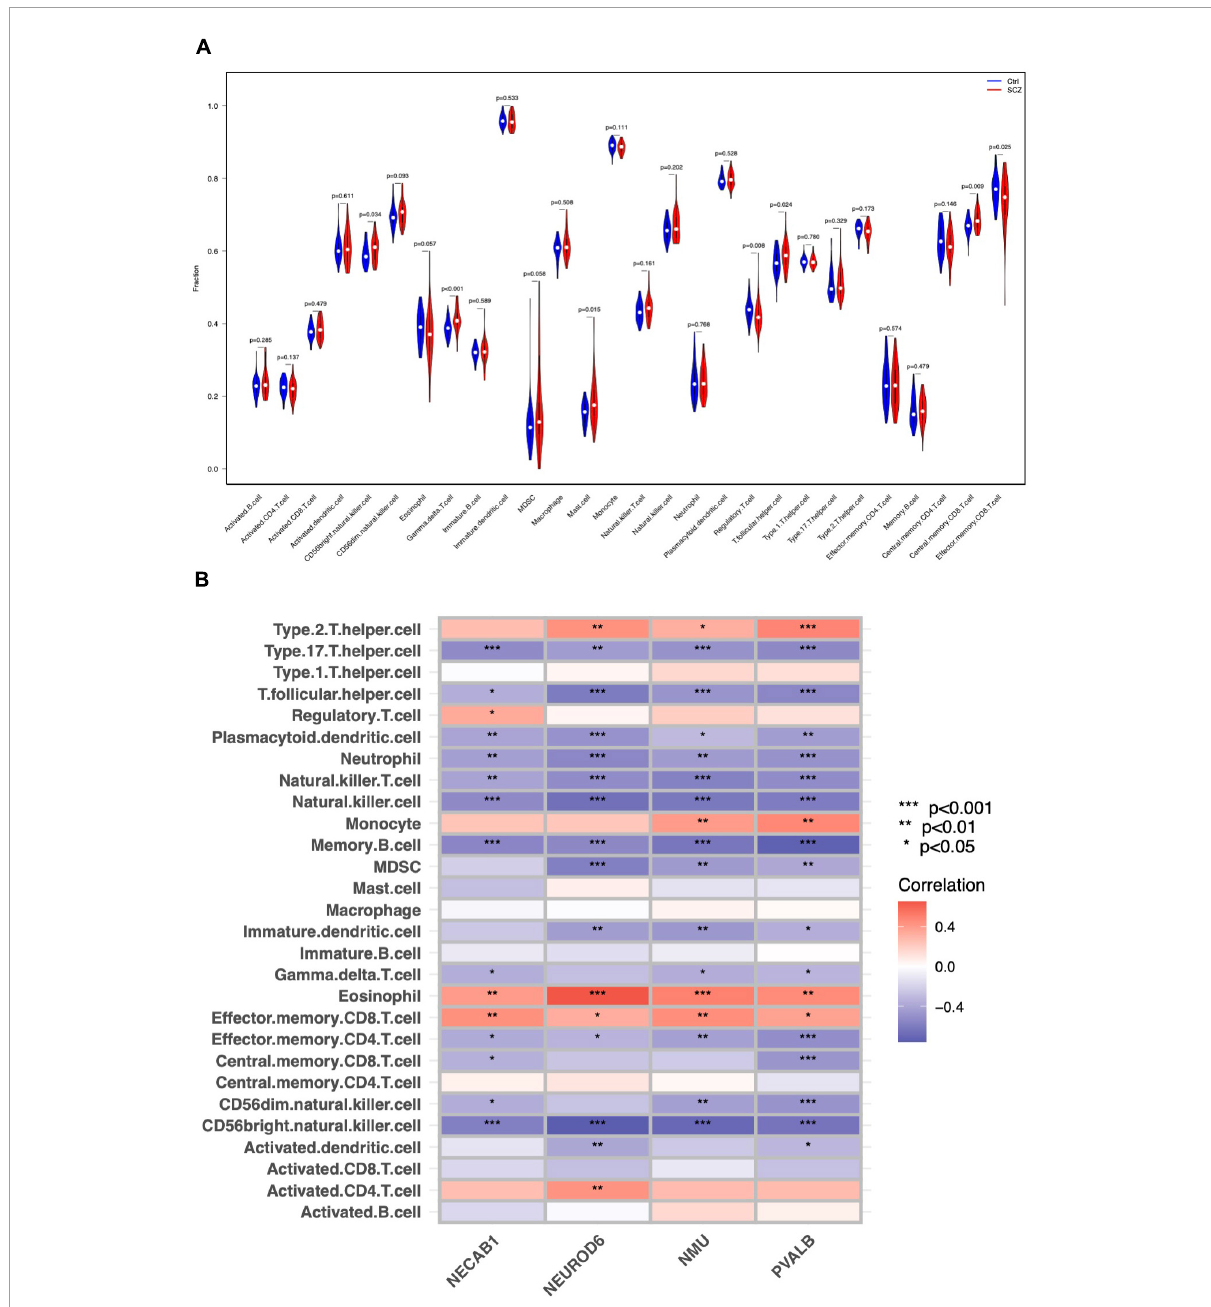
FIGURE9 Immune cell distribution in SCZ. (A) Differences in infiltrated immune cells between SCZ and control groups. (B) Correlation analysis between hub genes and immune